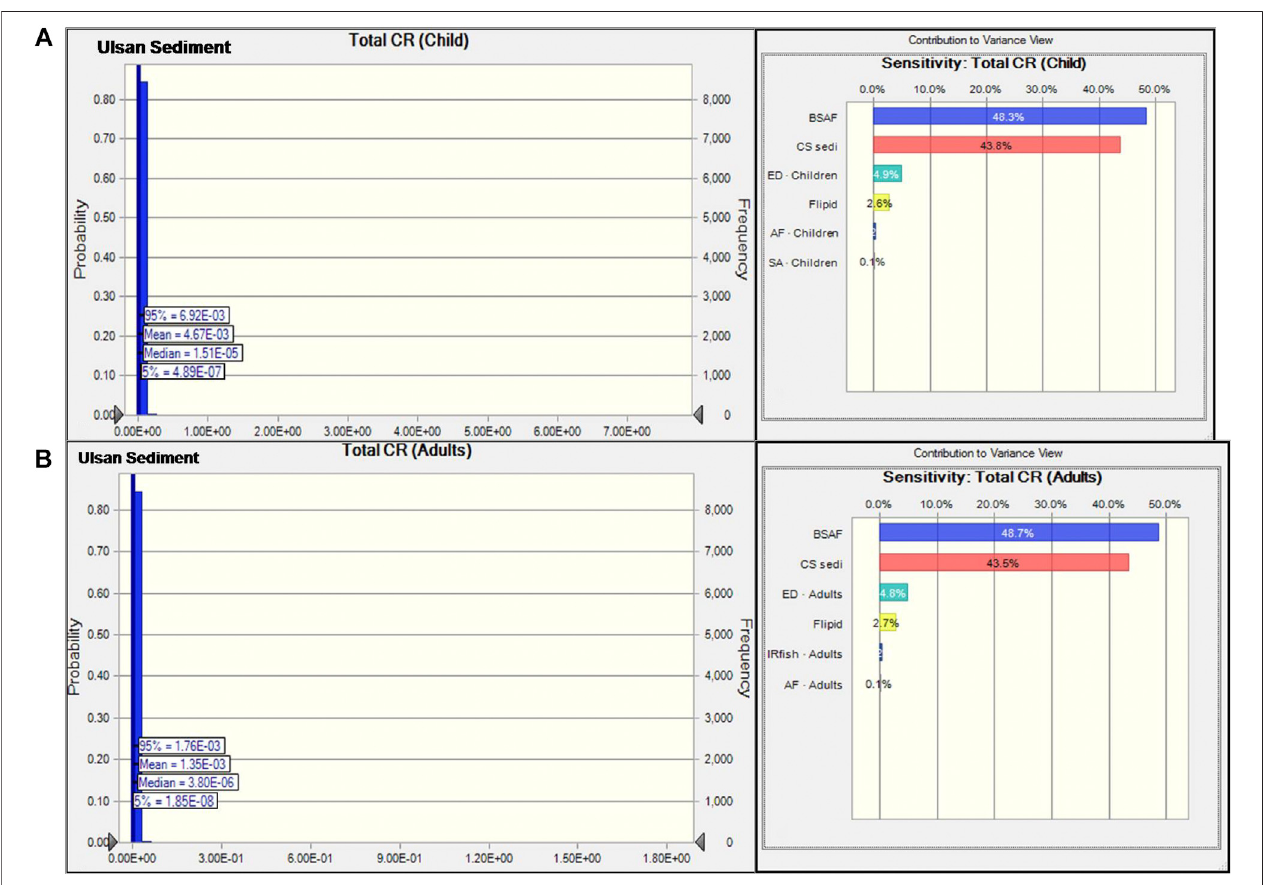
FIGURE2| Probabilitydensity functionsand sensitivity chartfromMonte Carlosimulationsusedtopredictthecancerriskfrom sediment-boundPAHs forchildren (A) and adults (B) in the Ulsan coastal area.